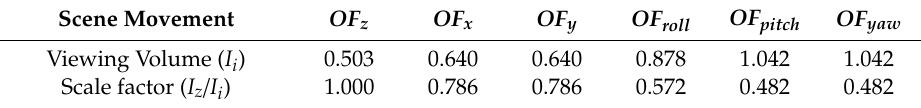
Table 1. Calculated viewing volume and scale factors for each movement direction. Scene Movement